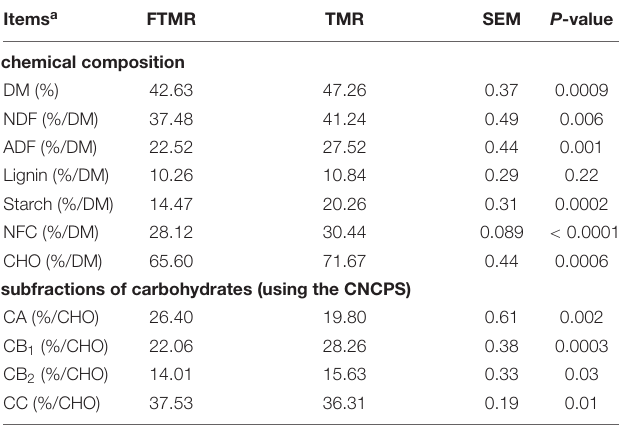
TABLE 2 | Chemical profiles and carbohydrate subfractions in fermented or non-fermented TMR.